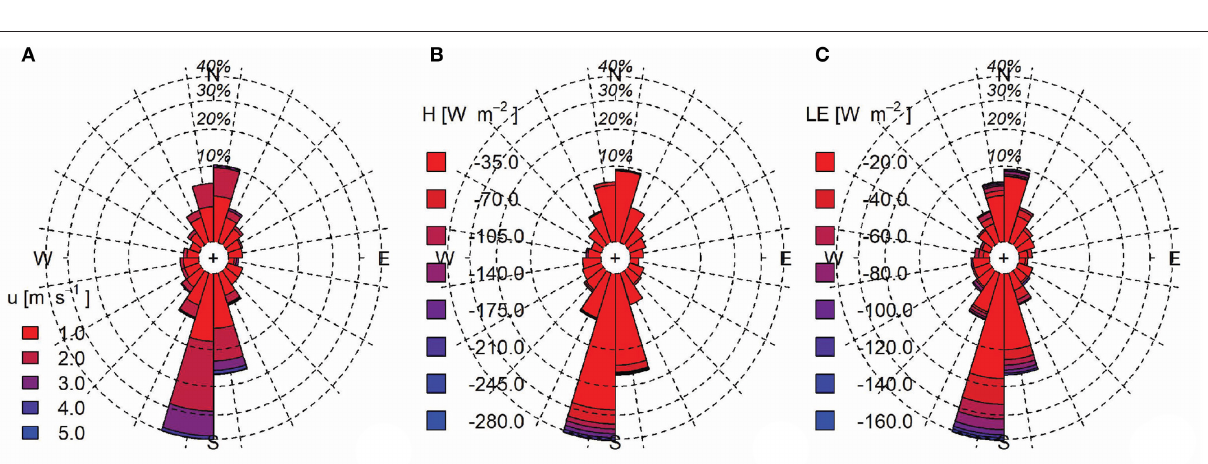
evaporation rates with a lysimeter on Lirung Glacier are one order of magnitude lower as well (Sakai et al., 2004), which could be explained by the lower wind speeds and temperature gradients